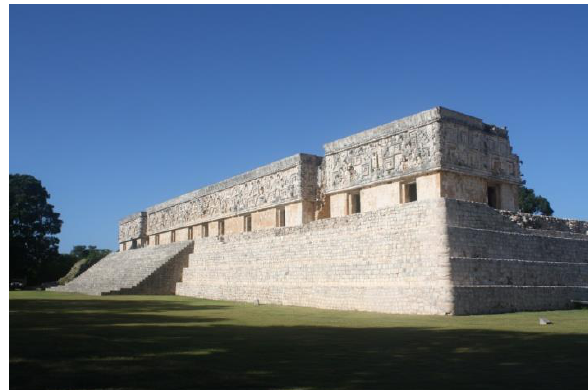
Figure 8. The Palace of the Governor at Uxmal, Mexico. (Photo Figure 11. South corbel-vaulted arch at the front facade of the G. Muñoz 2016). Palace of the Governor. (Photo G. Muñoz